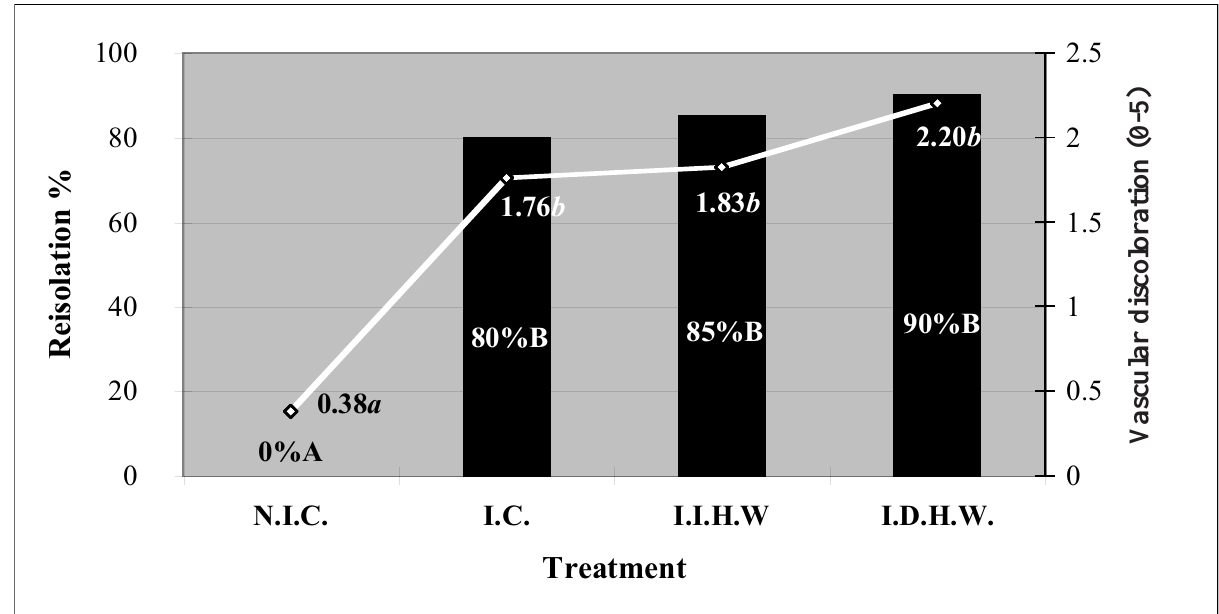
Fig. 1. Hot water treatment effect on colonization by Phaemoniella chlamydospora (histogram) and vascular discol- oration (line) on artificially inoculated grapevines ( Vitis vinifera cv. Cabernet Sauvignon). N.I.C., cuttings inoculat- ed with sterile water only and not treated in hot water; I.C., cuttings inoculated with Pa. chlamydospora and not treated in hot water; I.I.H.W., cuttings inoculated with Pa. chlamydospora and immediately treated in hot